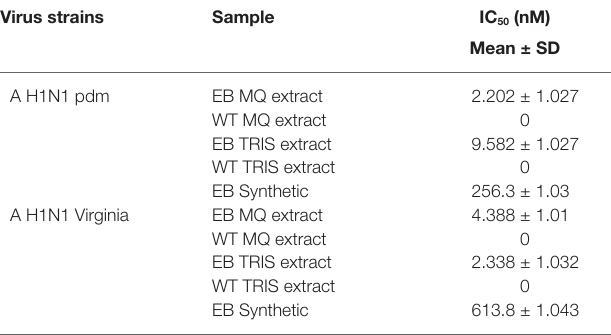
TABLE 1 | Hemagglutination inhibition of influenza virus by EB peptide. Virus strains